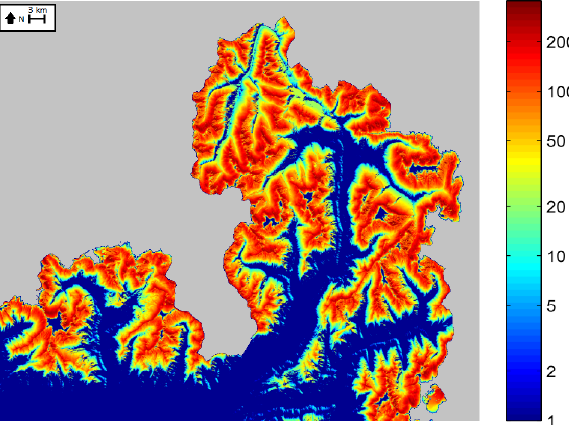
Fig.6. Displayonalogarithmicscaleofthesnowmapproducedby RBFN. Fig. 6. Display on a logarithmic scale of the snow map produced by RBFN.